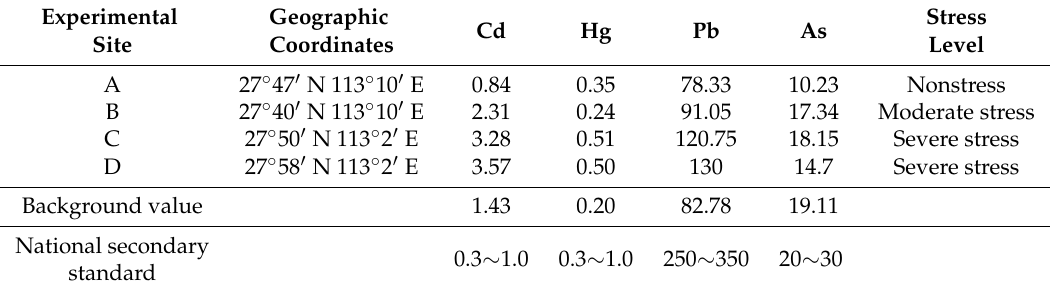
Table 1. The average condition of heavy metal contamination in the soil of the experimental sites. Experimental